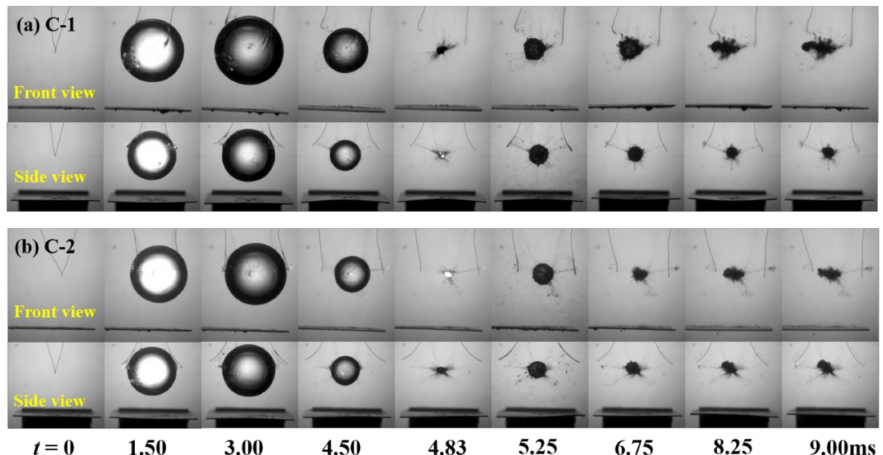
Figure 2. Front view and side view of the transient evolution of the bubble near ( a ) C-1 and ( b ) C-2 plates ( γ = 1.65).